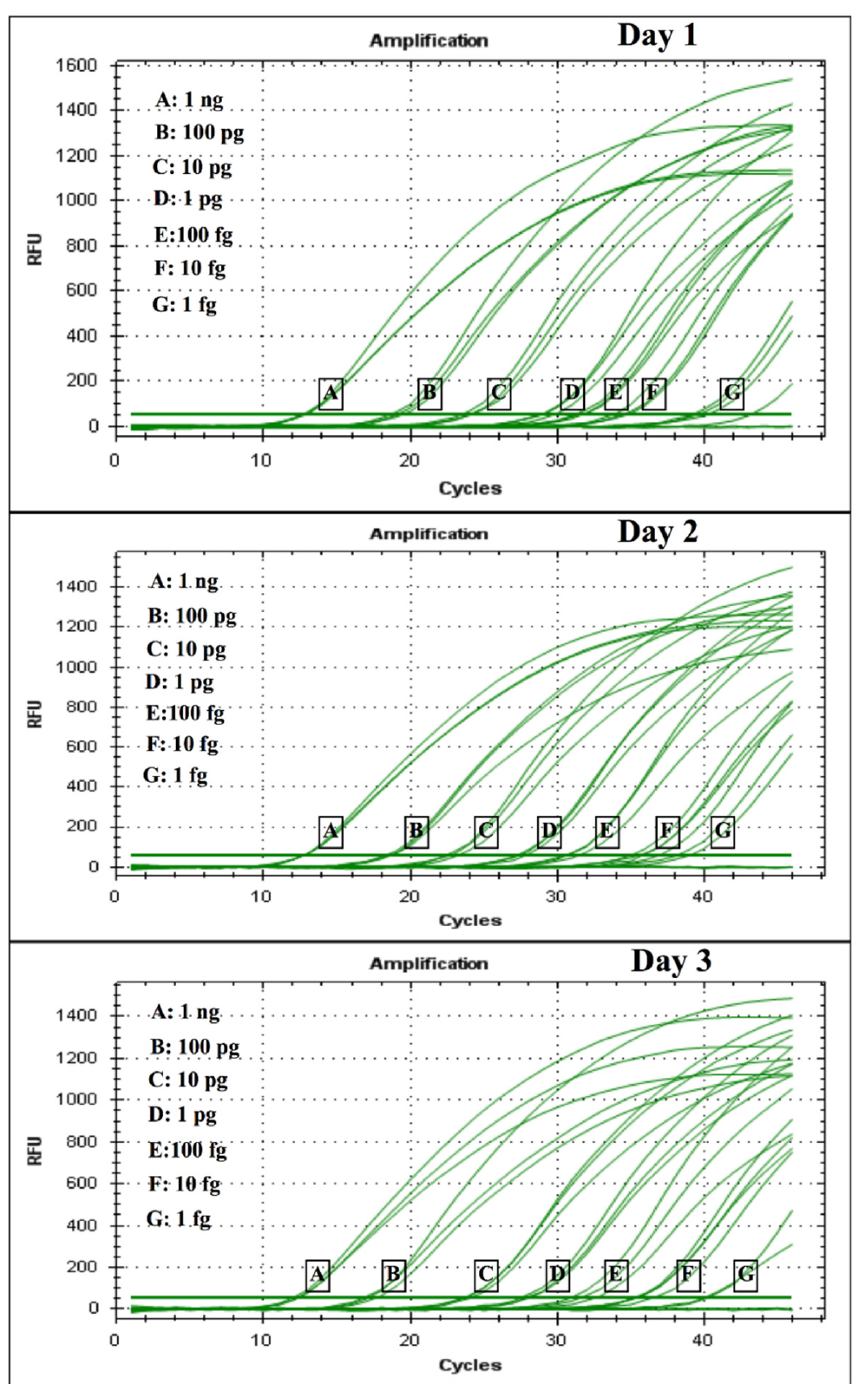
Figure 1. Standard curve for quantification obtained by using serial dilution 1:10 of different concen- trations of DNA plasmid positive control (pCR 2.1 + PPK inset).